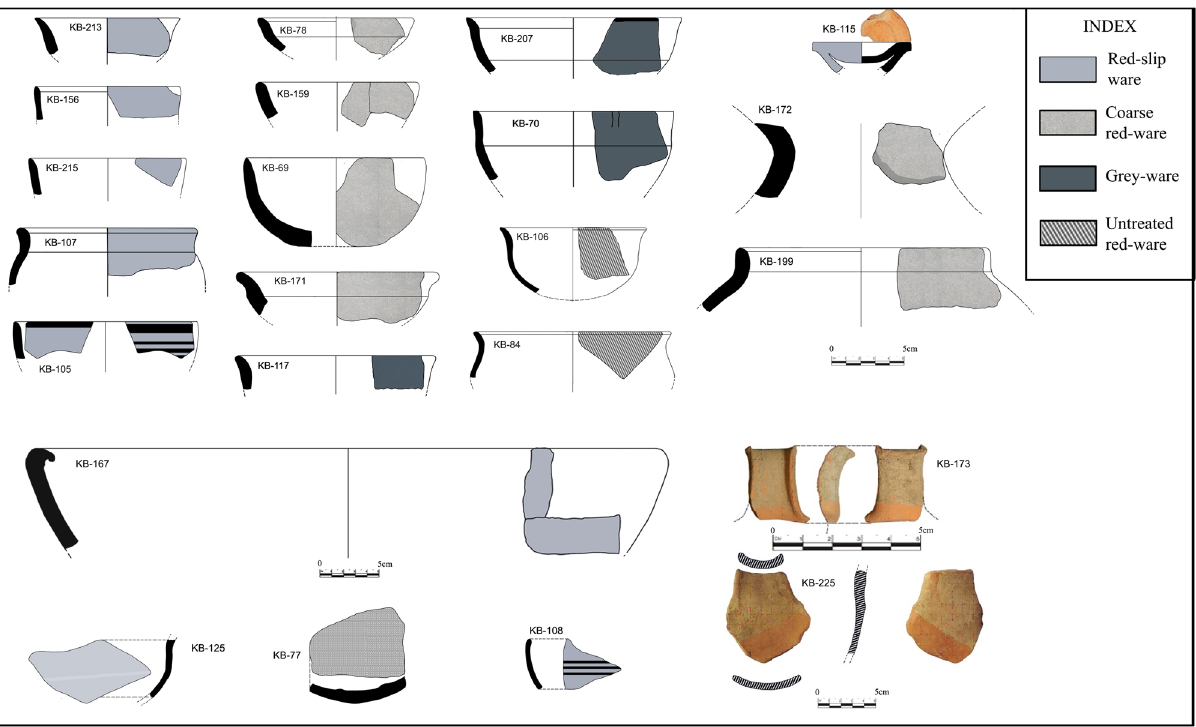
Figure 4. Reconstructed vessels from the settlement of Kotada Bhadli used for organic residue